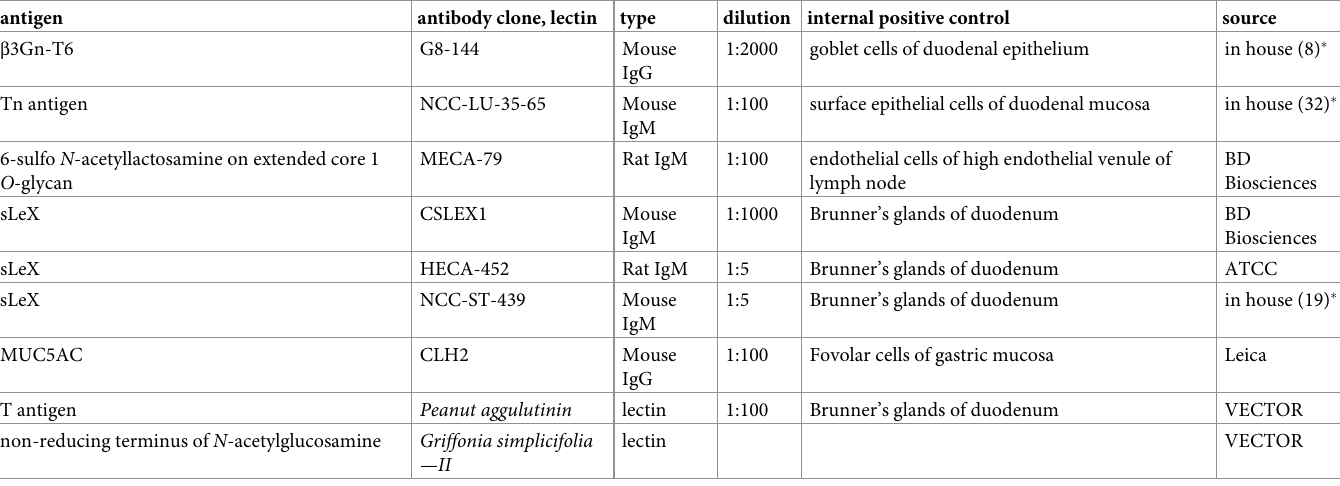
Table 2. Primary antibodies and